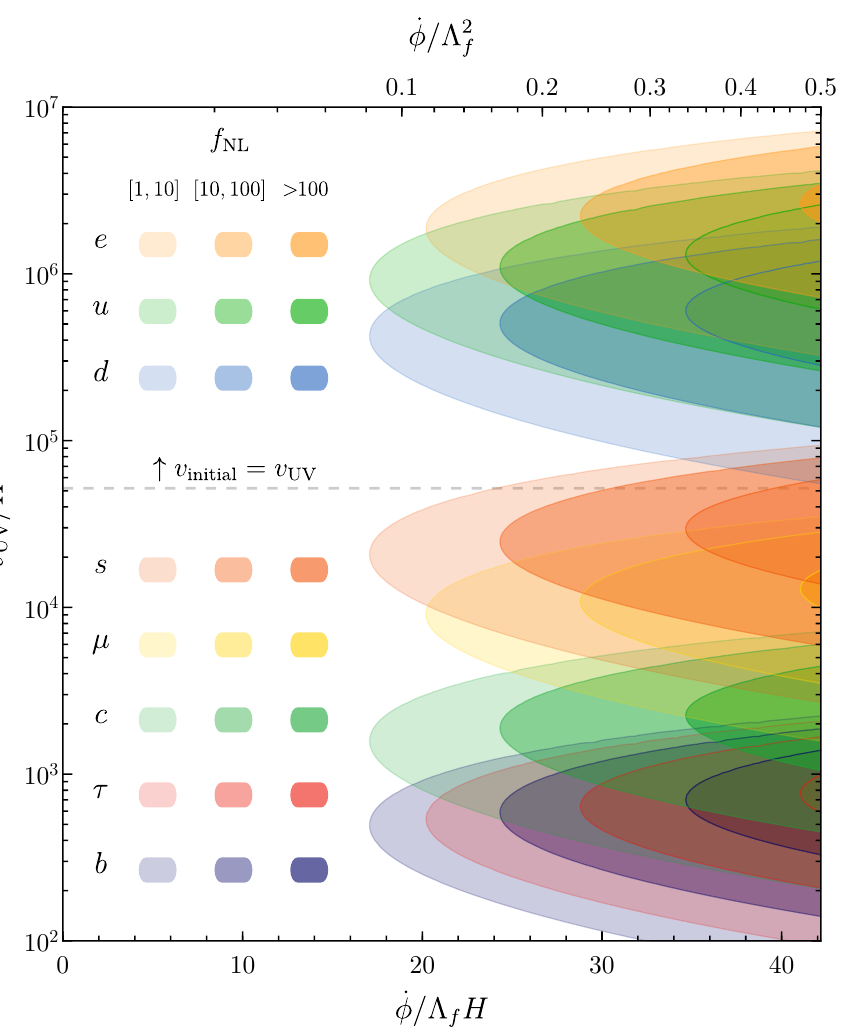
Figure 6 . The size of f NL that can generated by the production of SM fermions ( f 2 f b; (cid:28); c; (cid:22) , s; d; u; e g from bottom to top) during in(cid:13)ation as a function of the Higgs vev v uv in Hubble units and the strength of coupling e (cid:21) = _ (cid:30)= (cid:3) f H between the in(cid:13)ation and the SM fermions (we recall that we are setting c f = 1). In the range of the parameter space where H (cid:28) j (cid:21) h; uv j 1 = 2 v uv ’ 0 : 1 v uv i